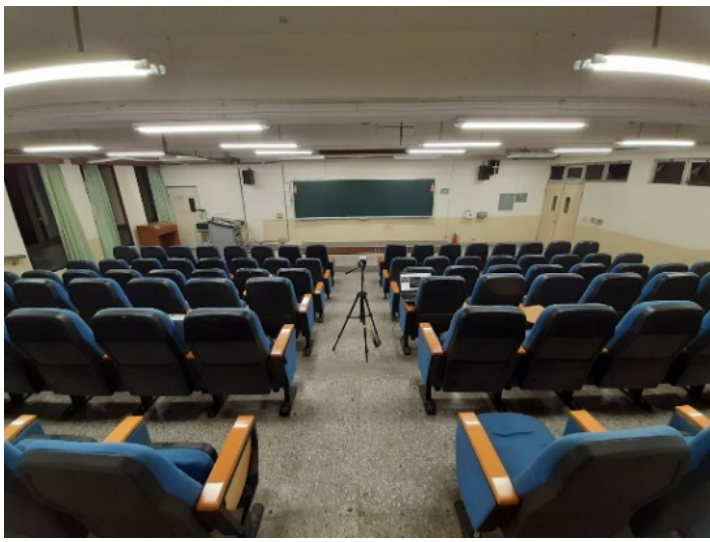
Figure 9. Application case (classroom EE-406) set up for clarity and luminance research.